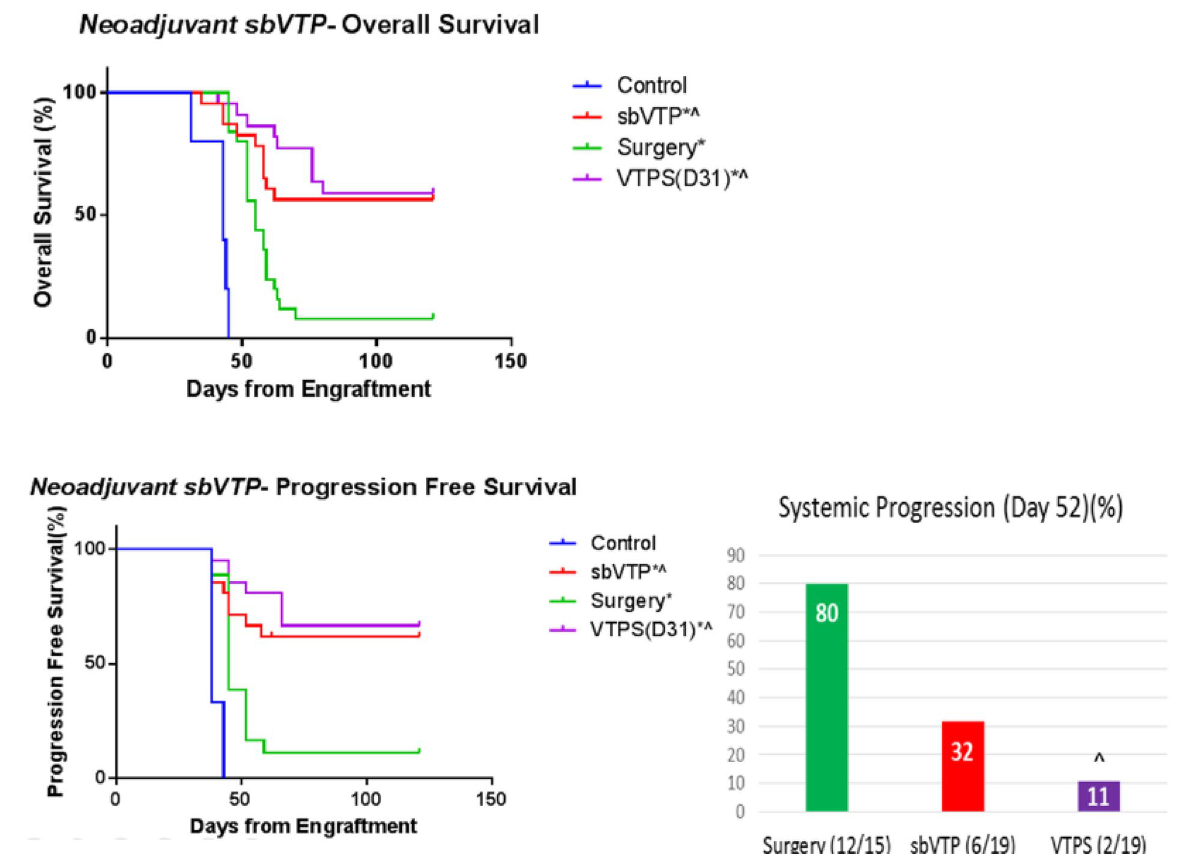
Figure 2. Kaplan–Meier analysis for overall survival and progression-free survival. Surgical resection was performed on day 31 for relevant groups (not illustrated). Control ( n = 5); sbVTP sub-ablative vascular targeted photodynamic therapy ( n = 23); Surgery ( n = 25); VTPS(D31) sub-ablative vascular-targeted photodynamic therapy followed by surgical resection of tumor 31 days from engraftment ( n = 22). Two and 3 animals were censored from the analysis in the sbVTP and VTPS groups, respectively, due to peri-procedure death. * P < 0.05 versus control; ^ P < 0.05 versus Surgery group. Note The improved survival presented for sbVTP at 2 weeks as compared to Fig. 1 is attributed to the different sizes of the treated tumors (see “Discussion”